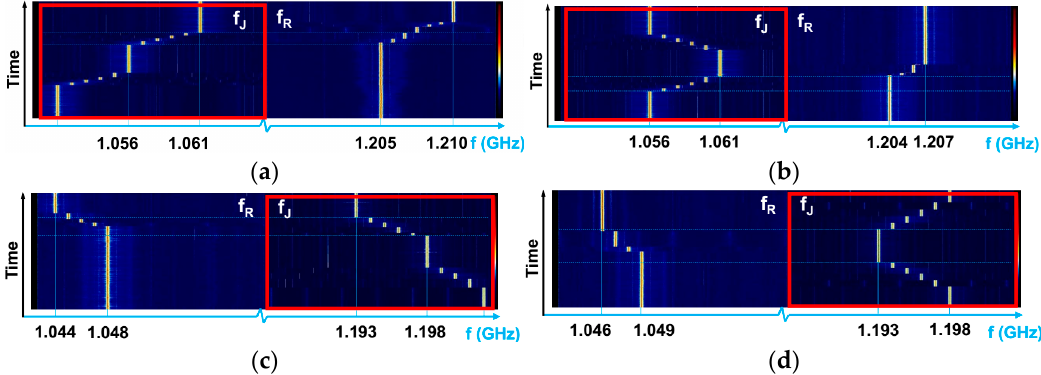
Figure 15. Spectral waterfall measurement of the photonic JAR in action with sinusoidal reference signal f R and jamming signals f J .( a ) The jamming signal f J is approaching f R from the low frequency side and triggers the JAR, ( b ) The jamming signal f J is approaching f R from the low frequency side and triggers the JAR, and then is moved away, ( c ) The jamming signal f J is approaching f R from the high-frequency side and triggers the JAR, ( d ) The jamming signal f J is approaching f R from the high-frequency side and triggers the JAR and then is moved away.